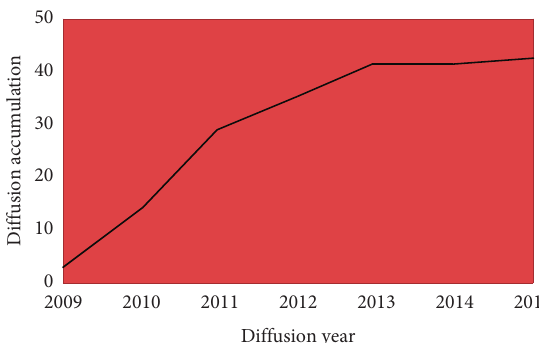
Figure 2: The construction diffusion time curve of 38 urban intelligent cities.